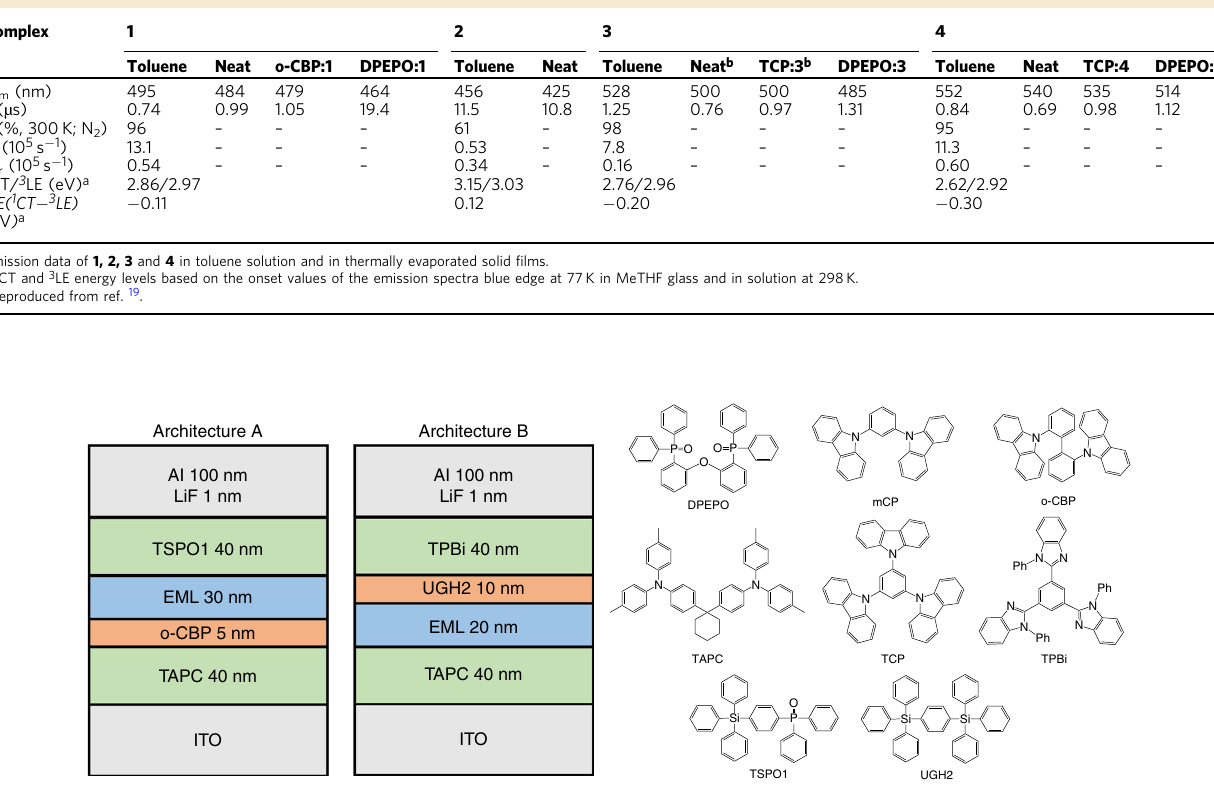
Fig. 3 Vapour-deposited OLED device architectures. OLED architectures A (for 1 and 2 ) and B (for 3 and 4 ) and chemical structures of the materials